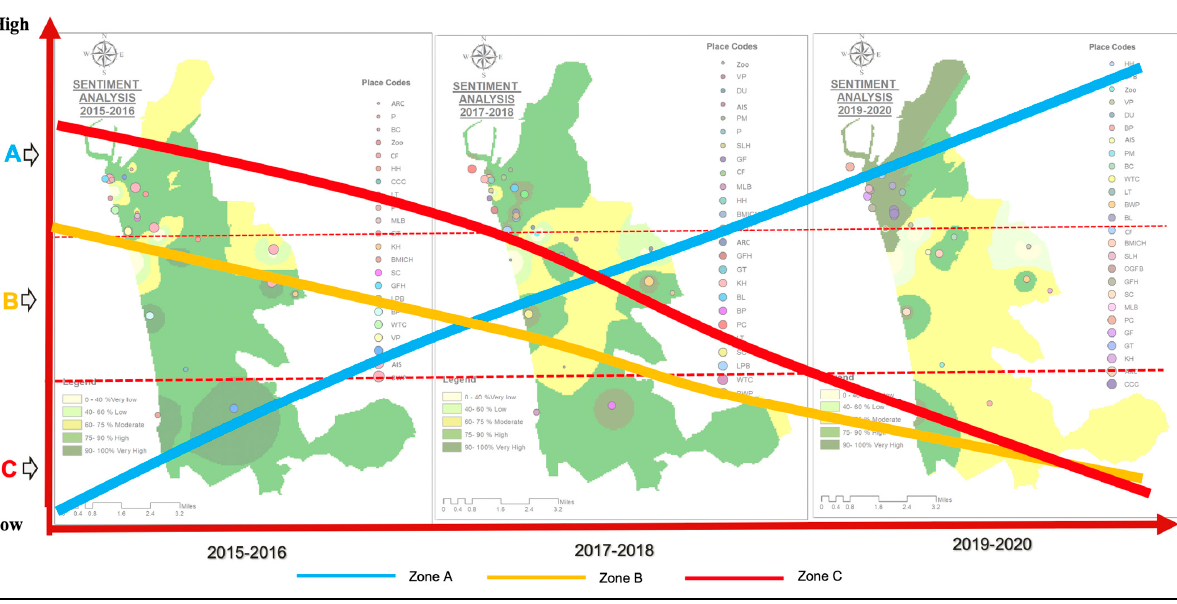
Figure 9. Temporal changes of the sentiment values by